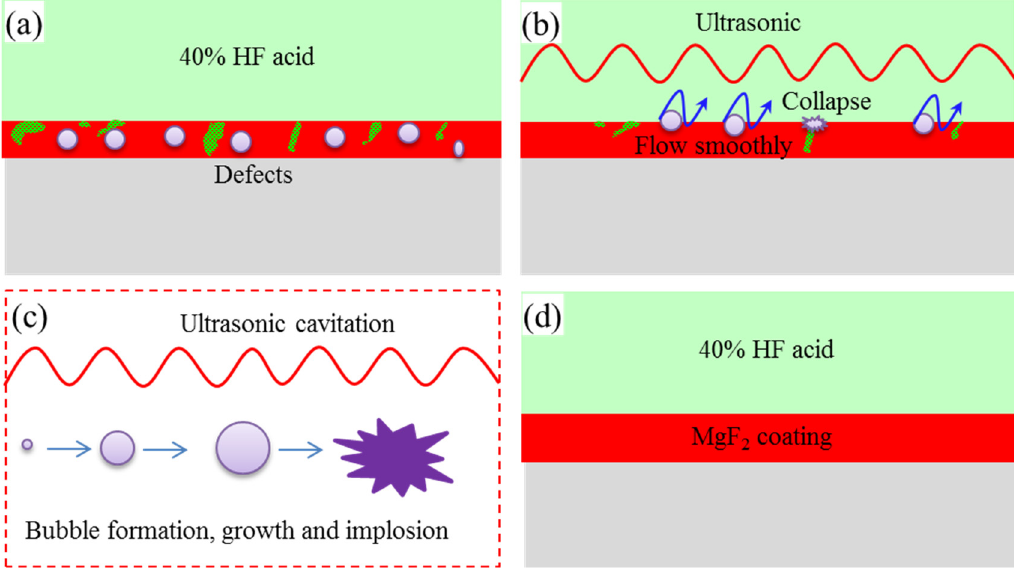
Figure 8. Schematic illustration of the protectiveness of F-treatment and U-treatment Mg alloys: ( a ) the F-treatment Mg alloy, ( b ) the U-treatment Mg alloy, ( c ) effects of ultrasonic cavitation during ultrasonic treatment in liquid conditions, and ( d ) the ultrasonically treated fluoride coating without defects of pores or cracks.